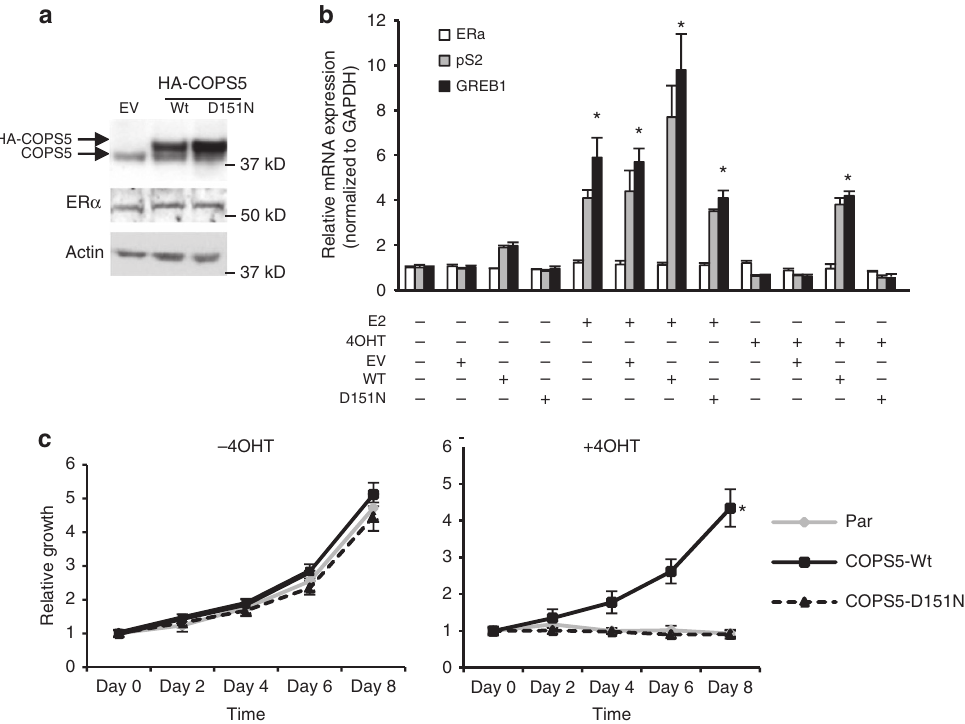
Figure 2 | Overexpression of wild-type COPS5 confers resistance to 4OHT. ( a ) Western blot analysis of COPS5 expression in MCF7 cell lines stably engineered with empty vector (EV), WTor D151N COPS5 cDNA. ( b ) Quantitative RT–PCR analysis of ER a and its target genes pS2 and GREB1 by ER a ligand treatment (48h) in MCF7 cell lines stably engineered with empty vector (EV), WTor D151N COPS5 cDNA. Data are presented as mean þ s.e.m. of three biological replicates. E2: 1nM, 4OHT: 500nM. *Significant difference compared with basal (untreated) levels ( P o 0.01, Student’s t -test). ( c ) Growth of MCF7 cell lines stably engineered with empty vector (Par), WTor D151N COPS5 cDNA in the absence or presence of 4OHT (1 m M). Data are presented